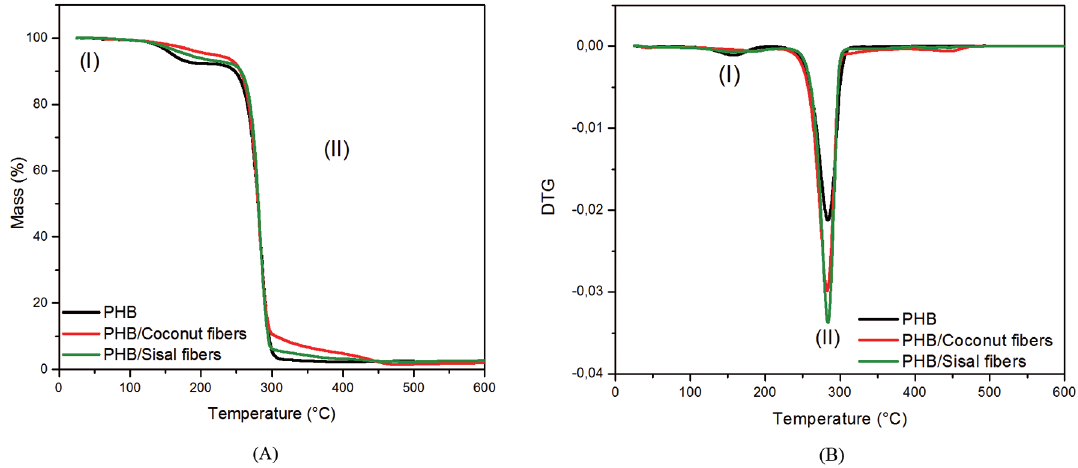
Figure 9: TGA curves (A) and DTG curves (B) of PHB plasticized with glycerol and composite PHB/coconut fibers and PHB/sisal fibers. Heating rate: 10 °C.min -1 under inert atmosphere flow of nitrogen 50 mL.min Table 3: Values of the initial temperature (T related to PHB and post-molding composites reinforced with coconut and sisal fibers mats.